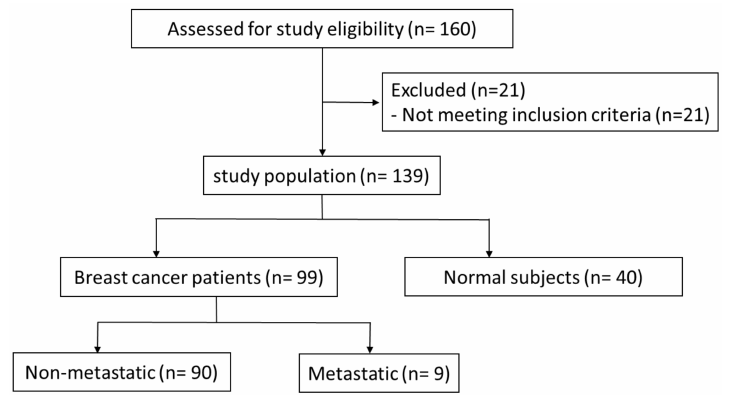
Figure 1. Stats of Primary BC patients and healthy